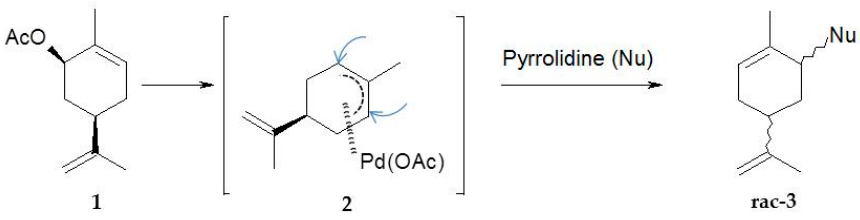
Figure 29. Proposed mechanism of Pd(0)-allylic amination of cis -carvyl acetate ( 1 ). Reproduced from [124] under the terms of the Creative Commons